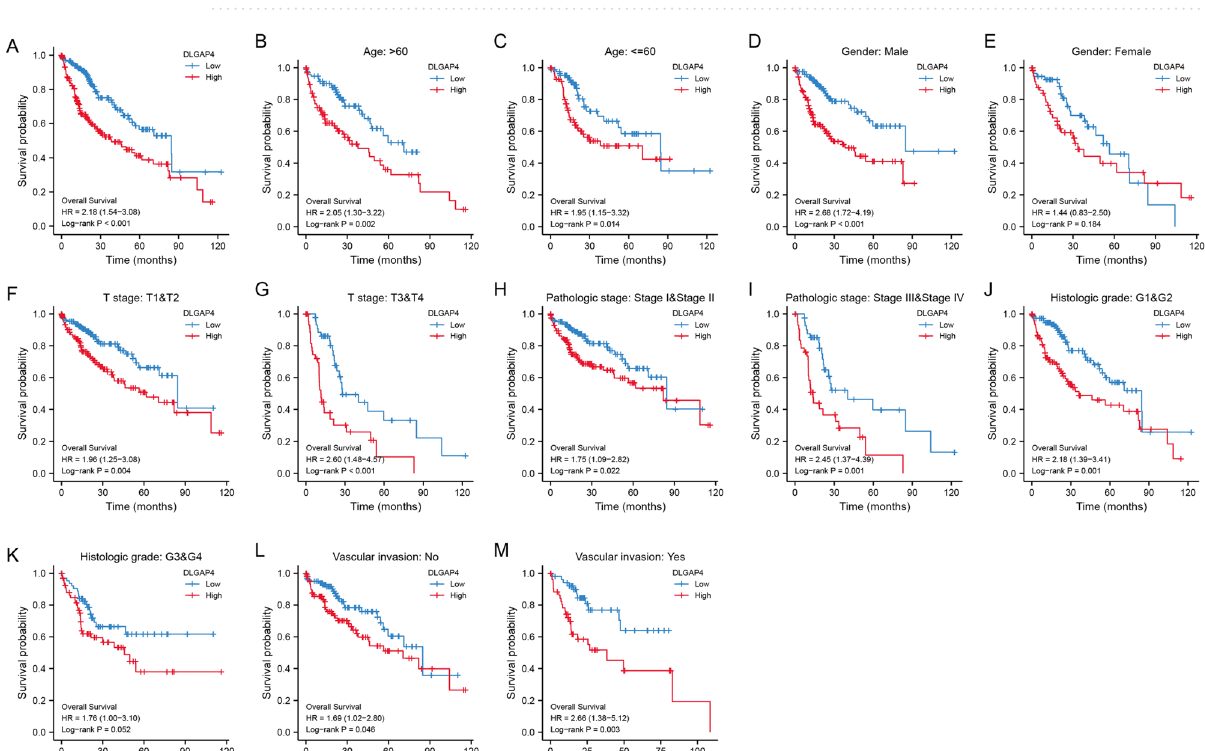
Figure 3. Kaplan ‒ Meier curve for the OS of HCC patients. ( A ) Kaplan ‒ Meier curves for all tumour patients grouped by DLGAP4 expression. ( B – Q ) Subgroup analysis based on age > 60 years ( B ), age ≤ 60 years ( C ), male ( D ), female ( E ), T1/T2 ( F ), T3/T4 ( G ), stage I/II ( H ), stage III/IV ( I ), G1/G2 ( J ), G3/G4 ( K ), vascular invasion: no ( L ), vascular invasion: yes ( M ). P < 0.05 indicates statistical